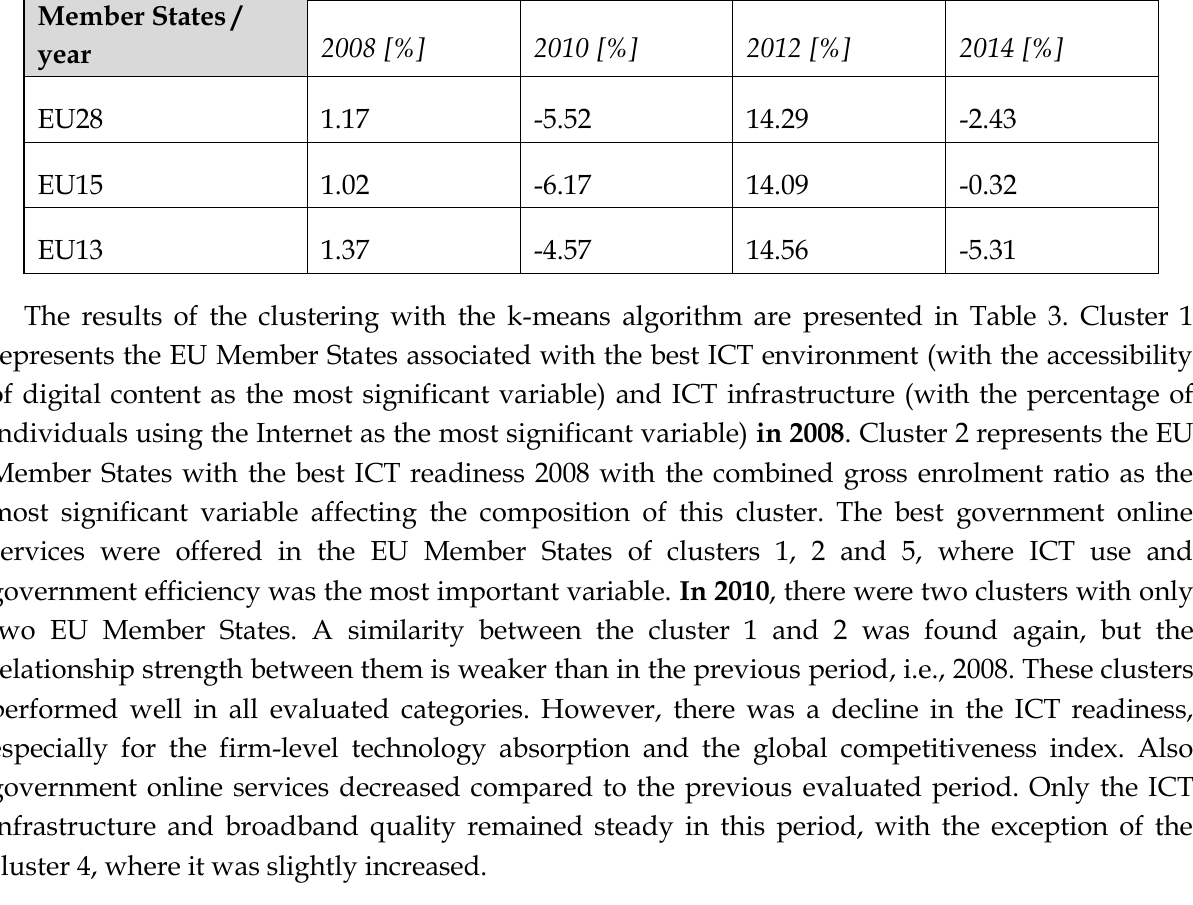
Table 4: A percentage change of the EGDI in the evaluated years Group of EU Member States